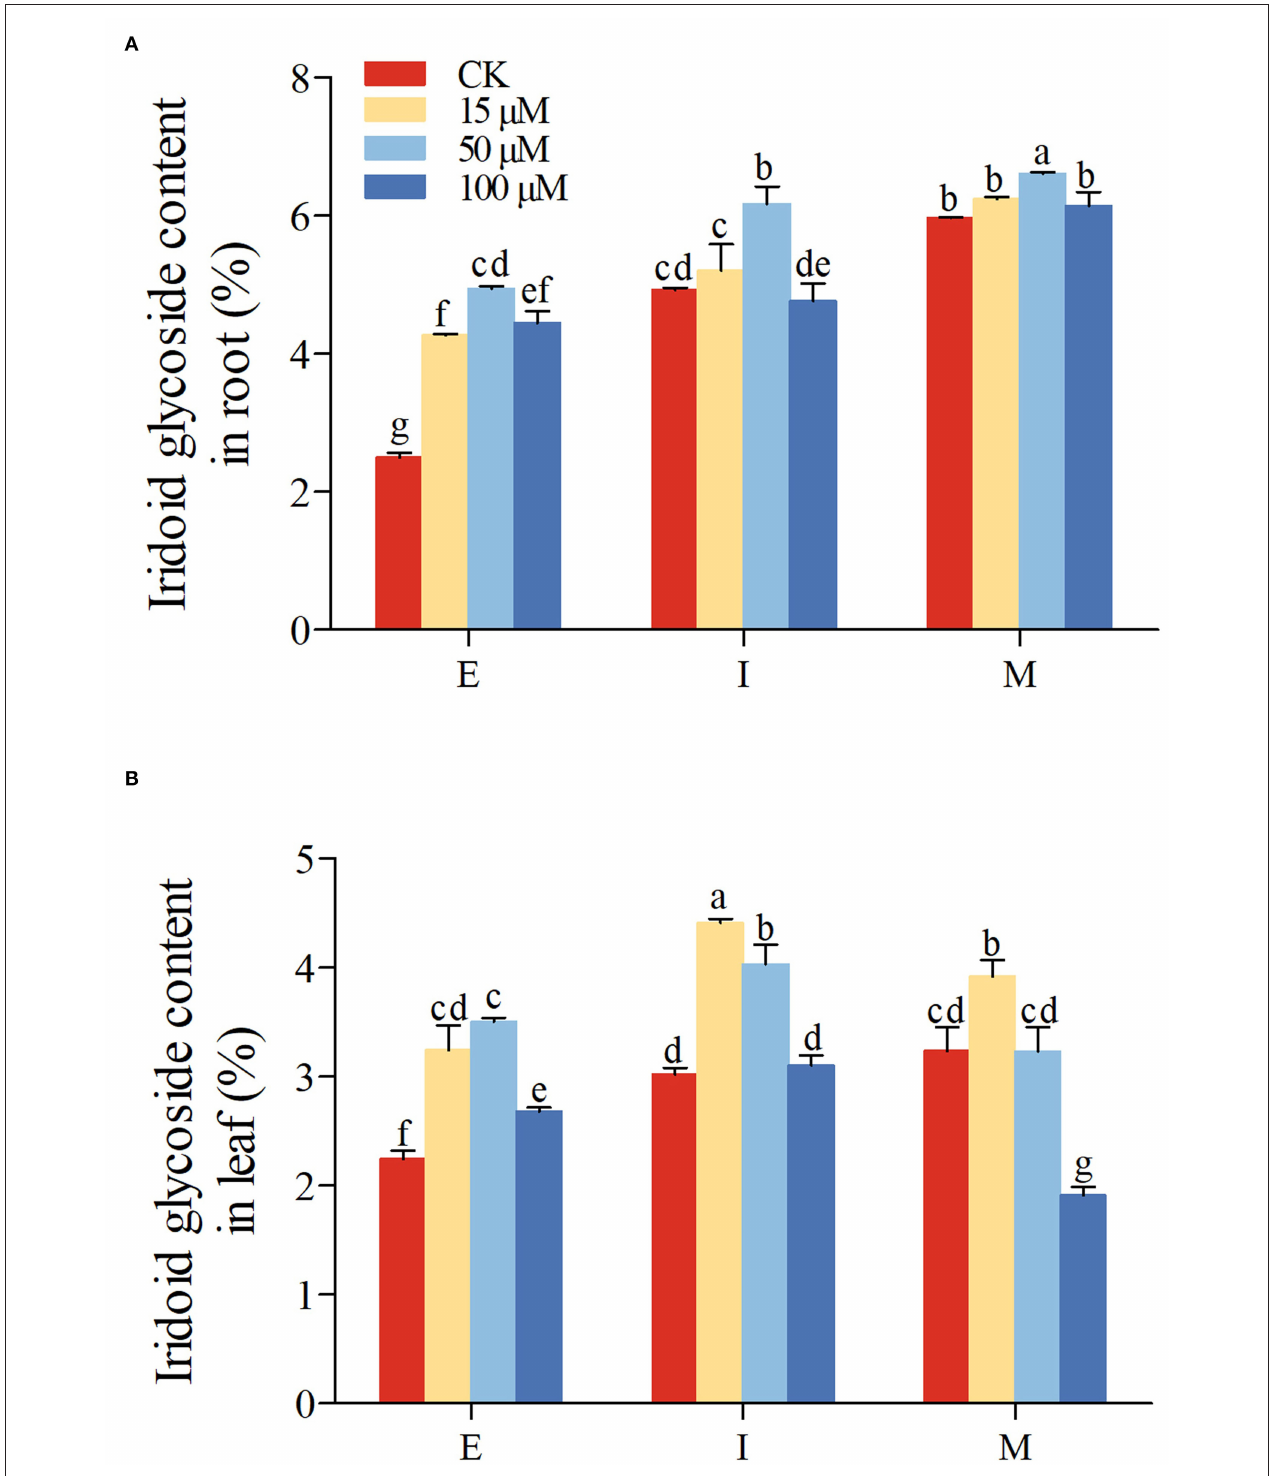
FIGURE 6 | Effect of 5-azaC on iridoid glycoside accumulation in R. glutinosa . (A,B) respectively, represent the content of iridoid glycoside in Jinjiu root and Jinjiu leaf of R. glutinosa , and E, I, and M represent elongation stage, intumescent stage, or maturation stage of R. glutinosa , separately. The error bar is standard error of mean, and the lower letter above the bar indicates the significant difference in root and leaf among different growth stages of R. glutinosa ( P < 0.05).